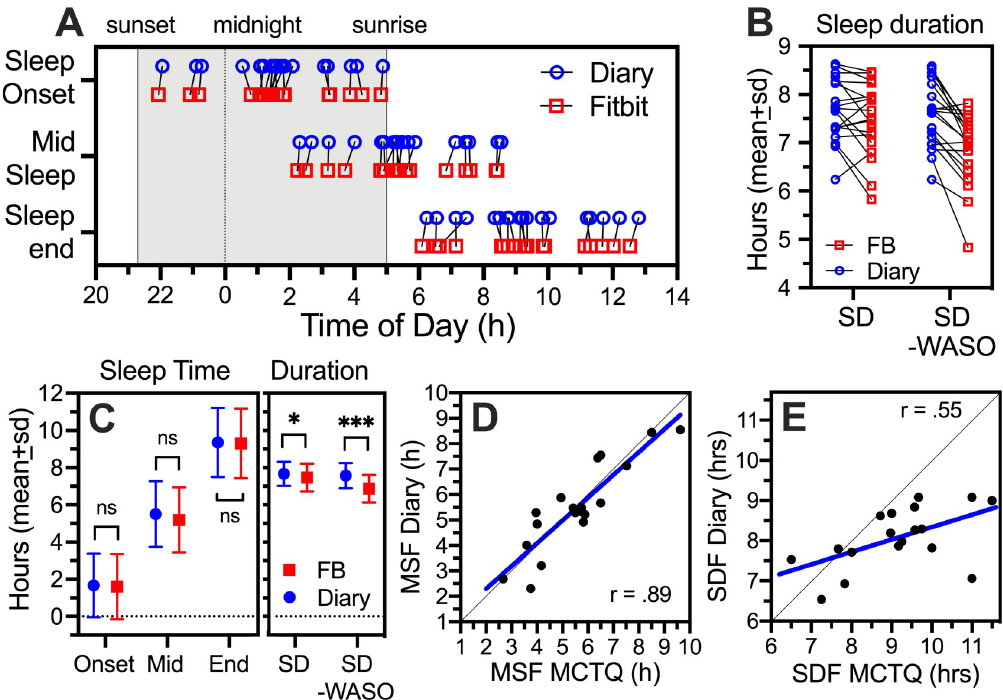
Fig 1. Comparison of sleep timing and duration from sleep diaries and Fitbit (FB) sleep trackers from a 2020 subgroup (N = 19). [A]. Sleep onset, midsleep and sleep end in individual subjects based on sleep diaries (blue circles) and Fitbits (red squares). Grey shading denotes night time, with sunset and sunrise times corresponding to late June in Vancouver, Canada. Hour 0 denotes midnight. [B]. Sleep duration (SD), in hours between sleep onset and end, and adjusted for reported wake- after-sleep-onset (SD-WASO). [C]. Group mean ( ± standard deviation) sleep onset, midsleep, sleep end, and sleep duration, from diary and FB data. [D]. Scatterplot of midsleep on free days (MSF) from diary and MCTQ data. [E]. Scatterplot of sleep duration on free days (SDF) from diary and MCTQ data. Paired t-tests, � p < .05, ��� p <